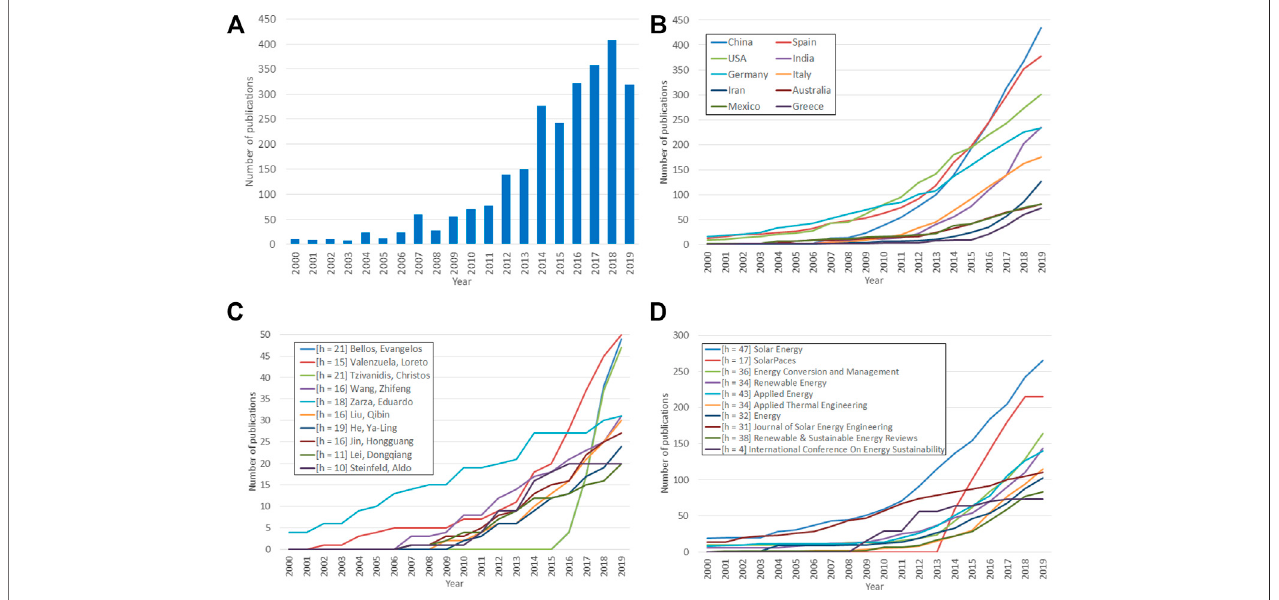
FIGURE 12 | (A) Total publications evolution in the Parabolic Trough fi eld per year; (B) Total publications in the parabolic trough fi eld per country; (C) Publication evolution of the parabolic trough fi eld per country; (D) Cumulative author evolution in the parabolic trough fi eld by number of publications.